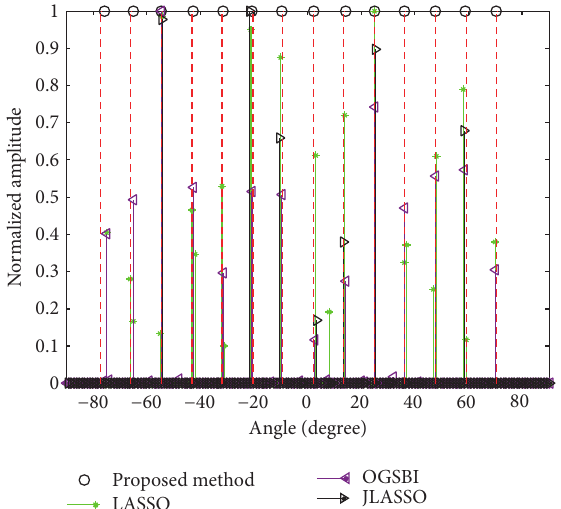
Figure 8: Spatial spectrums of LASSO, OGSBI, and the DOA results of the proposed method (𝐾 = 14,𝜆 𝑡 = 0.25) .